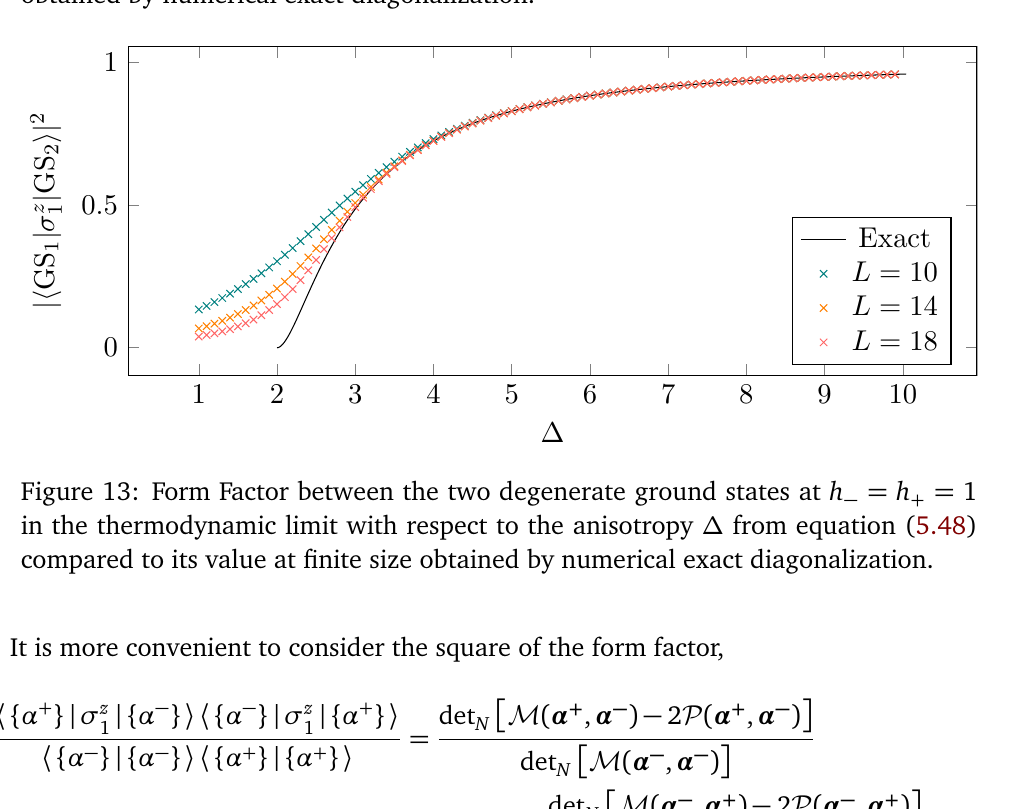
(cid:128) (cid:138) 8 1 − e − 2 n ζ = (cid:81) ∞ , compared to its value at finite size n = 1 0 1 + e − 2 n ζ